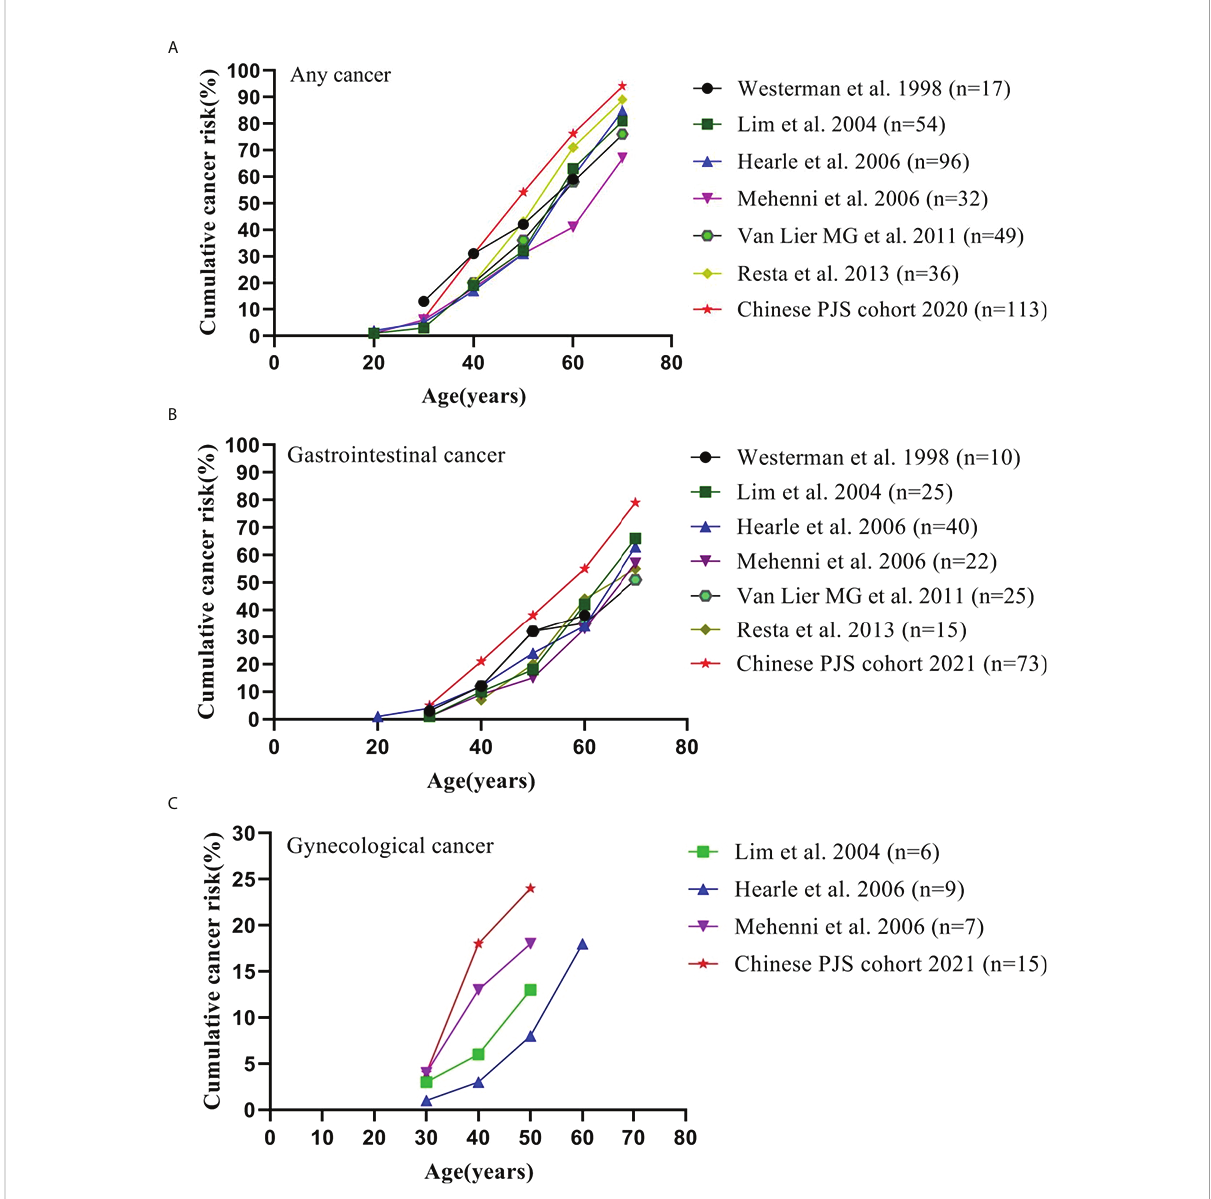
FIGURE 2 Cumulative cancer risk according to age. (A) Cumulative risk for any cancer; (B) Cumulative risk for gastrointestinal cancer; (C) Cumulative risk for gynecological